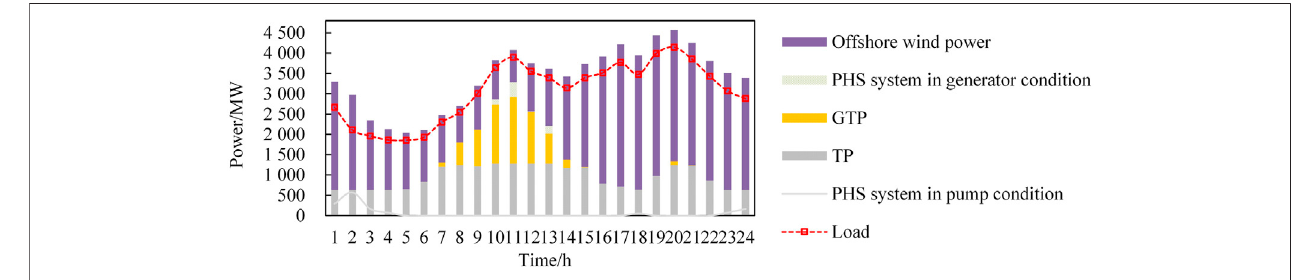
FIGURE 7 | Operation planning result for scenario 3.